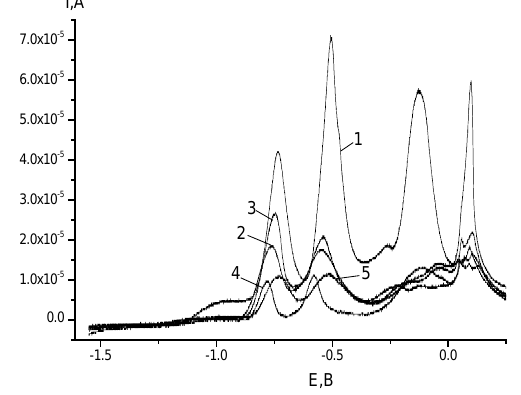
Fig.1. Stripping voltammograms of test system with Lanomax solutions of different concentrations: (1) test system; (2) 1∙10 -7 0.25% Lanomax; (3) 2∙10 -7 0.25% Lanomax; (4) 3∙10 -7 0.25% Lanomax; and (5) 4∙10 -7 0.25% Lanomax. Then, filter paper disks saturated with the Lanomax solution of different concentrations were successively placed on this electrode and stripping voltammograms were recorded and compared to the background voltammogram. Figure 1 shows how the stripping voltammogram changes with the concentration of Lanomax (curves 2 to